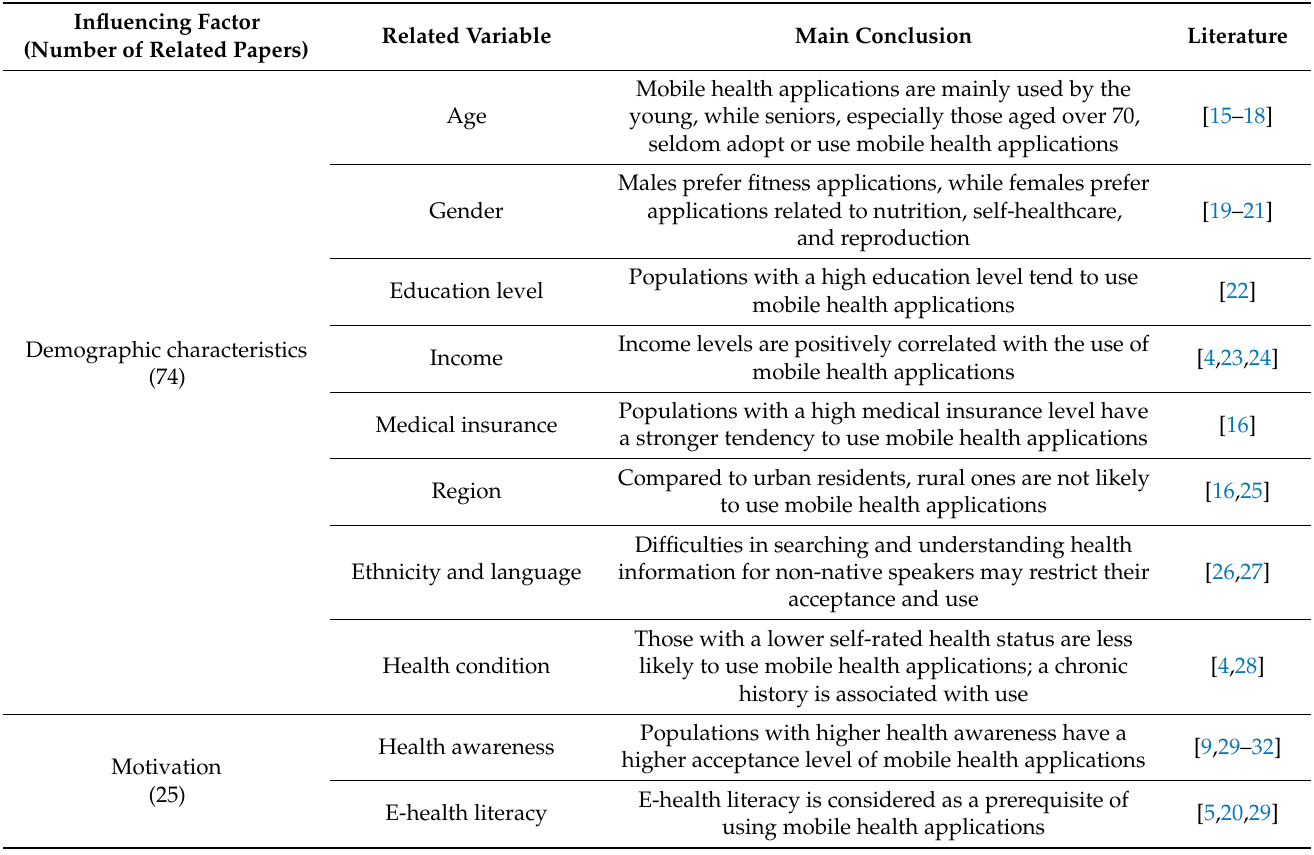
Table 2. Influence of individual factor in use